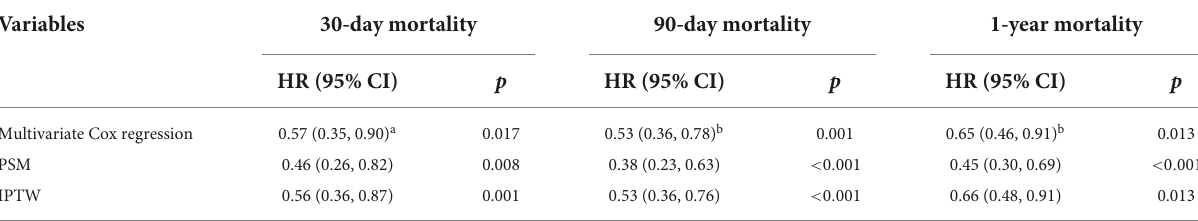
TABLE 4 Association between the excessive body mass index (BMI) and mortality in critically ill patients with acute ischemic stroke.